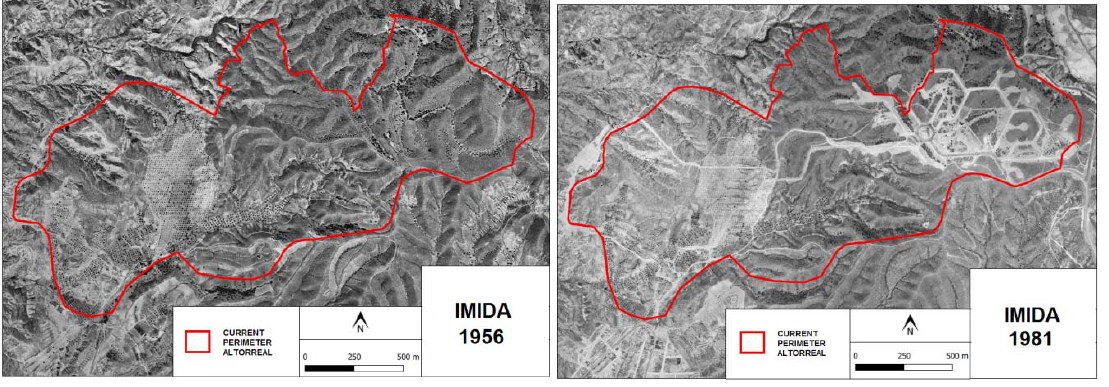
Figure 4. Evolution of the land surface built in Altorreal since 1990. Figure 5. The starting point of the Altorreal Golf Resort. In the new millennium, the urban fabric of the Altorreal resort kept increasing. In 2000, 93 ha were already built (56.8% of total resort), and 125 ha were surpassed in 2005 (Figure 6).